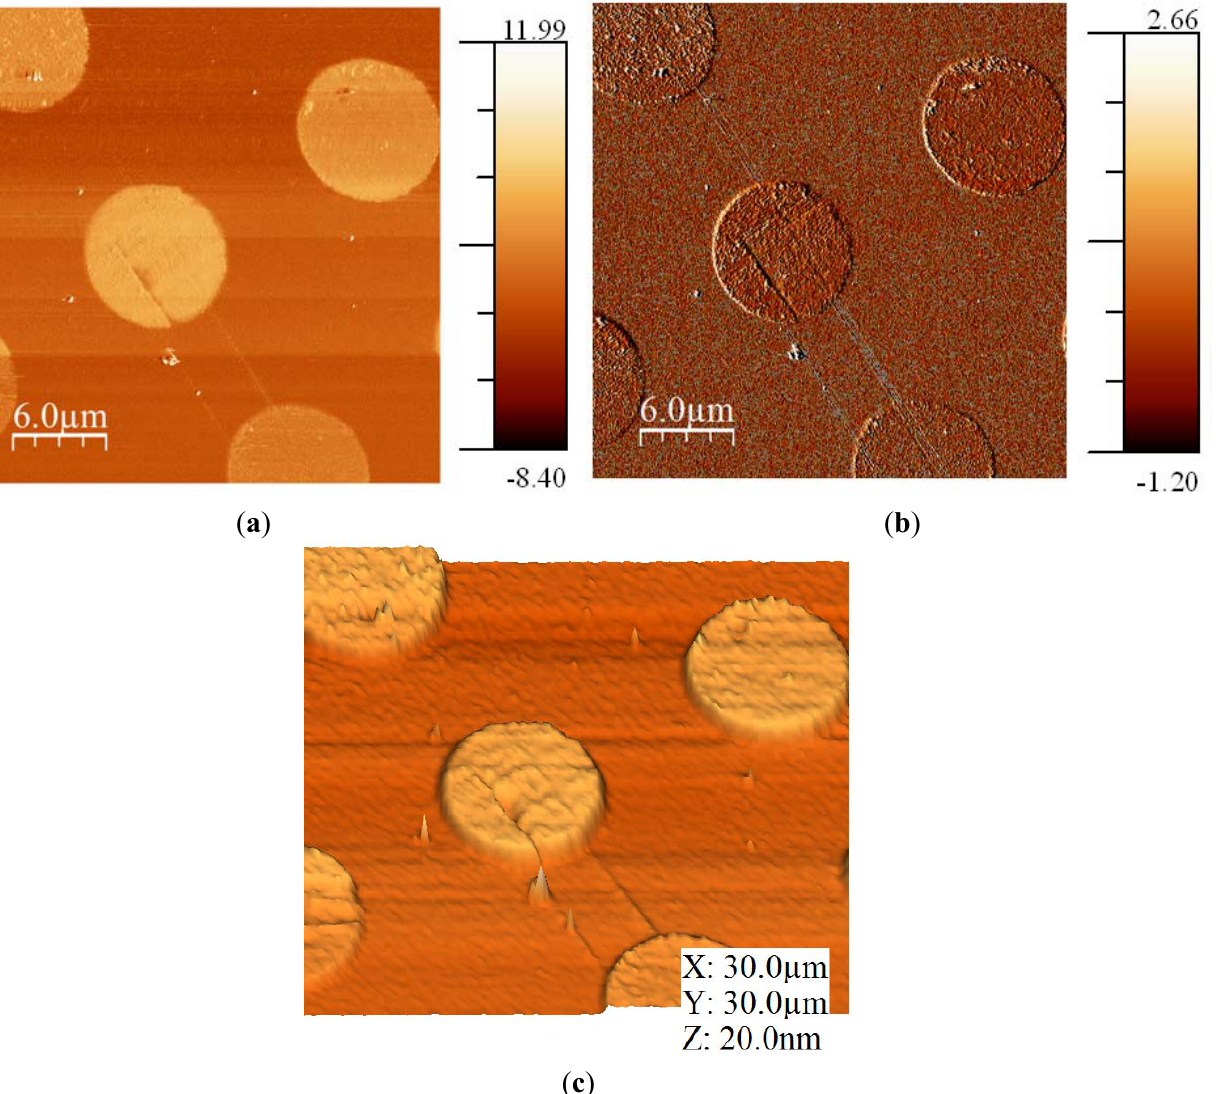
Figure 9. ( a ) Topography image of microcontact printed antibodies acquired in amplitude modulation with PLL (Z scale in nanometer); ( b ) Error image (amplitude, Z scale in nA); ( c ) 3D